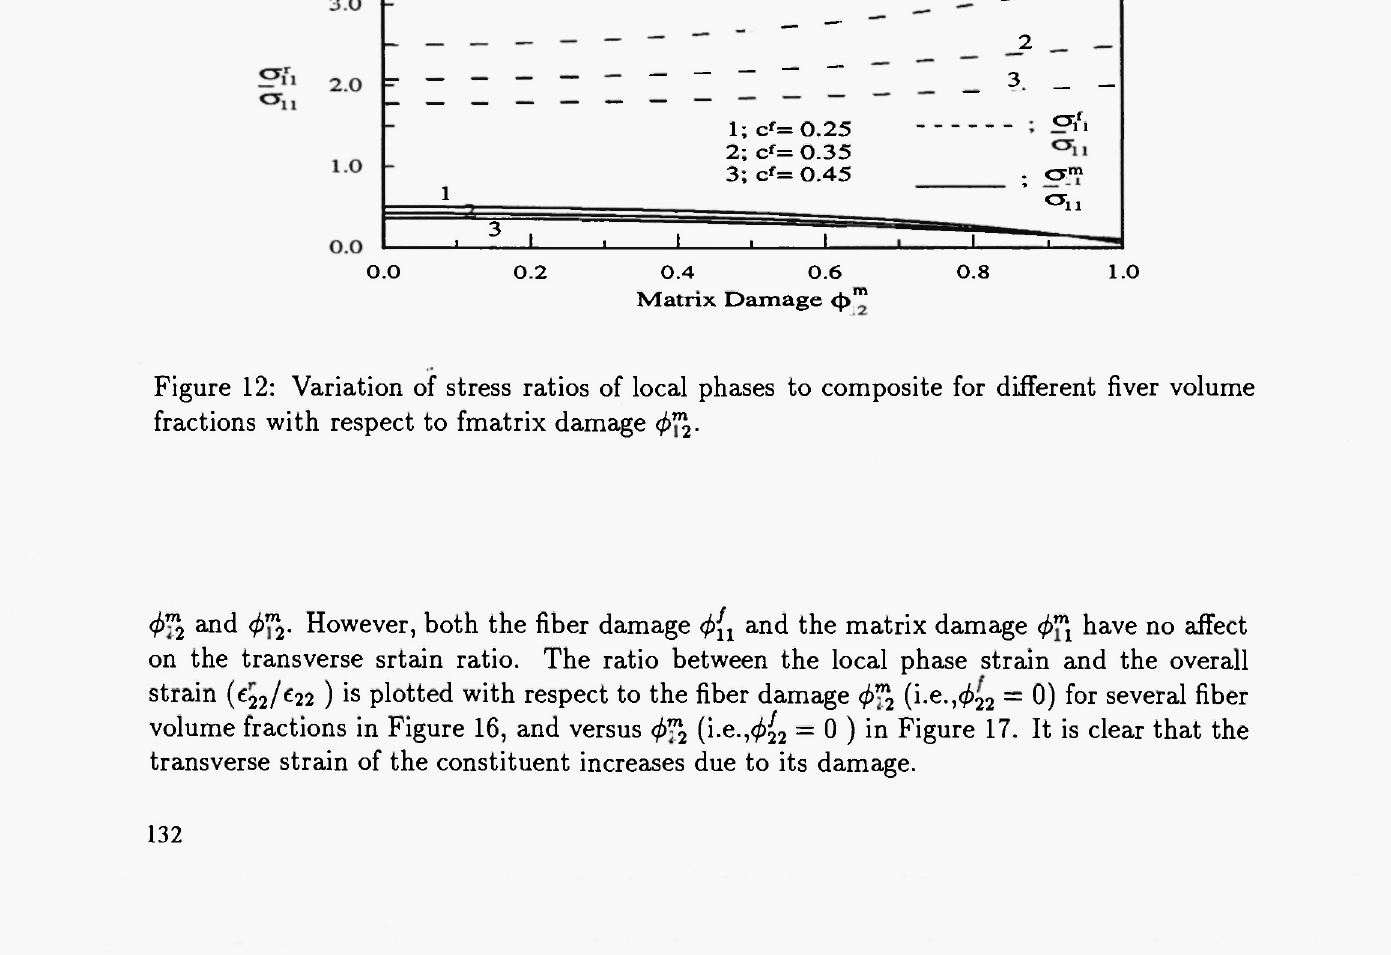
Figure 11: Variation of stress ratios of local phases to composite for different fiver volume fractions with respect to fiber damage φ{ 2 .